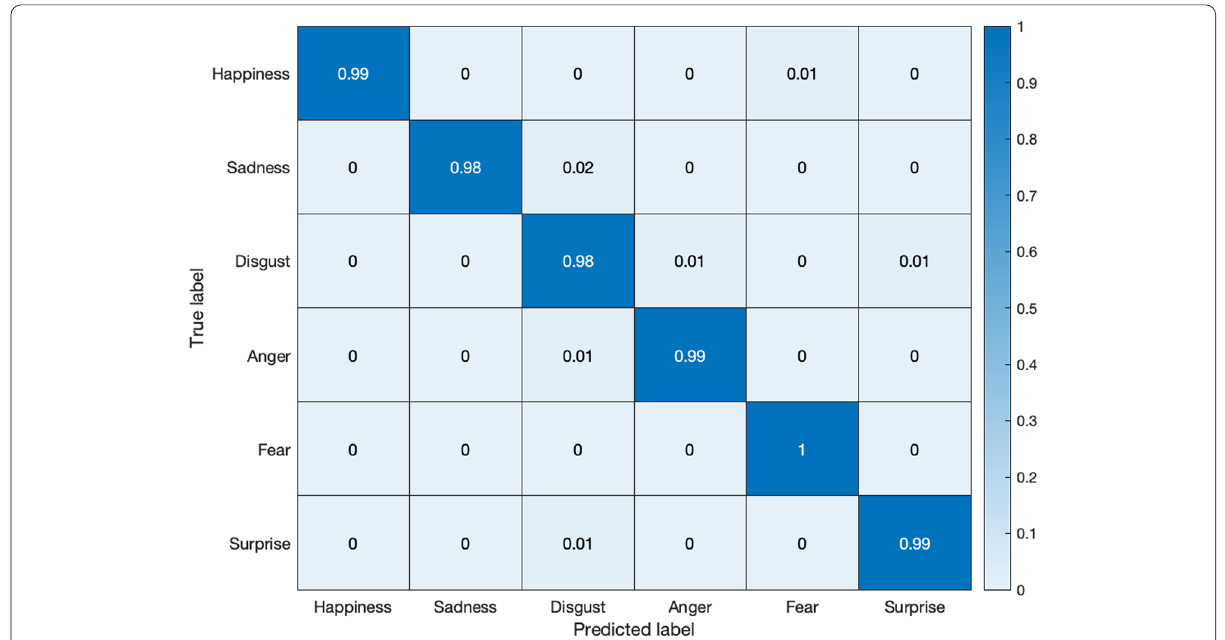
Fig. 11 Confusion matrix of facial expressions in